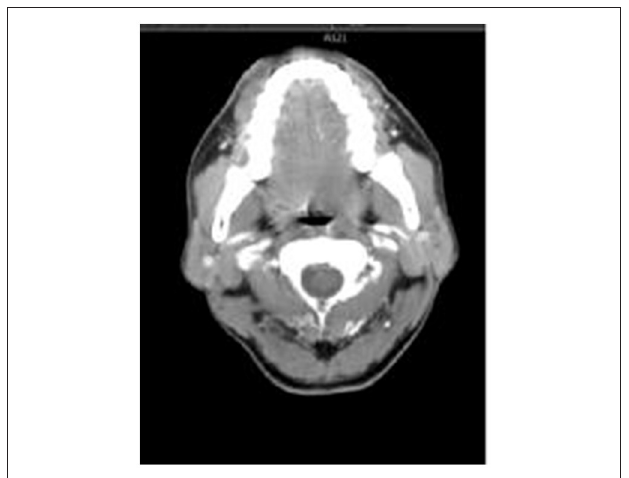
FIGURE 5 | Swallowing artifacts: In the non-tongue-out group, swallowing artifacts were visible in the bilateral palatine tonsils and tongue root, and there were no artifacts in the cervical